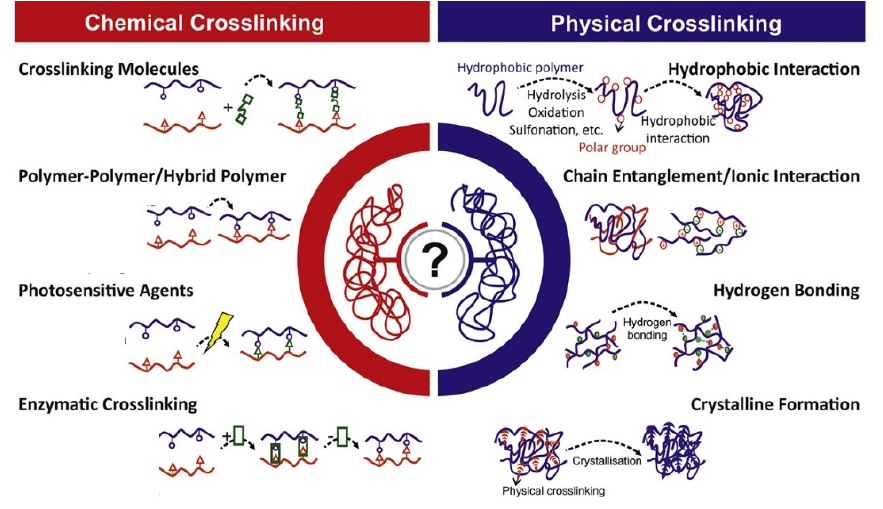
Figure 2. Schematic representation of various types of physical and chemical crosslinking in hydro- gels (adapted from [22], CC-BY license). gels (adapted from [22], CC-BY